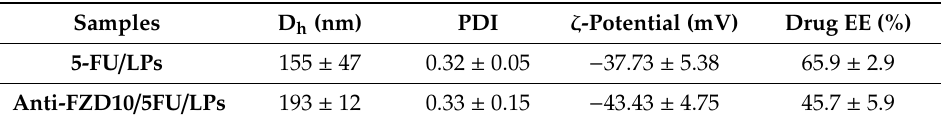
Table 1. Intensity-average hydrodynamic diameter and corresponding polydispersity index (PDI) determined by Dynamic Light Scattering (DLS), ζ -potential, and encapsulation e ffi ciency (EE%) of 5-FU / LPs and anti-FZD10 / 5-FU / LPs.